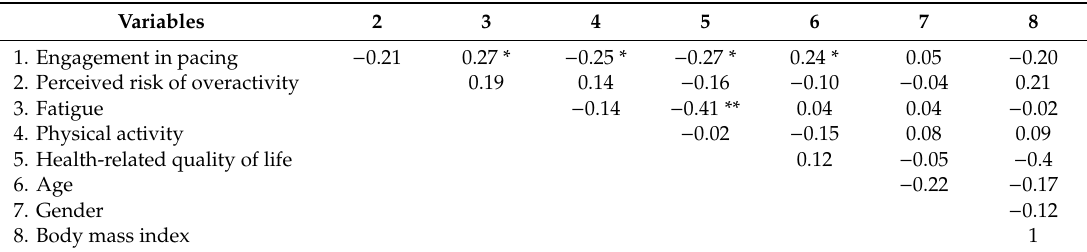
Table 2. Bivariate Pearson correlations of all variables in the hierarchical linear regression models.